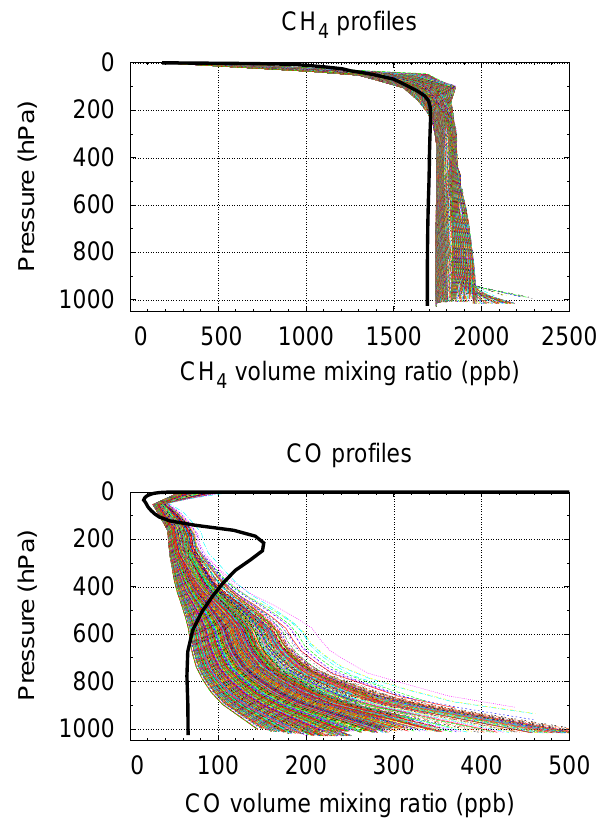
Fig. 14. The heavy black lines show the prior profiles of CH 4 and CO 2 . Both are derived from simulations with the MOZART chemi- cal transport model, and both are described as “transport” scenarios. The fine coloured lines show the true profiles for one orbit (number 4) of the simulations.